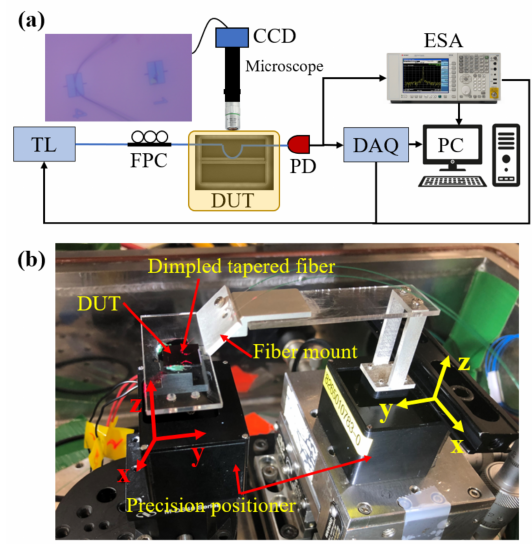
Figure 4. ( a ) Experimental system (light-yellow rectangular box indicates the device under test (DUT) test in the vacuum chamber); ( b ) alignment setup of the fiber taper-DUT under a vacuum